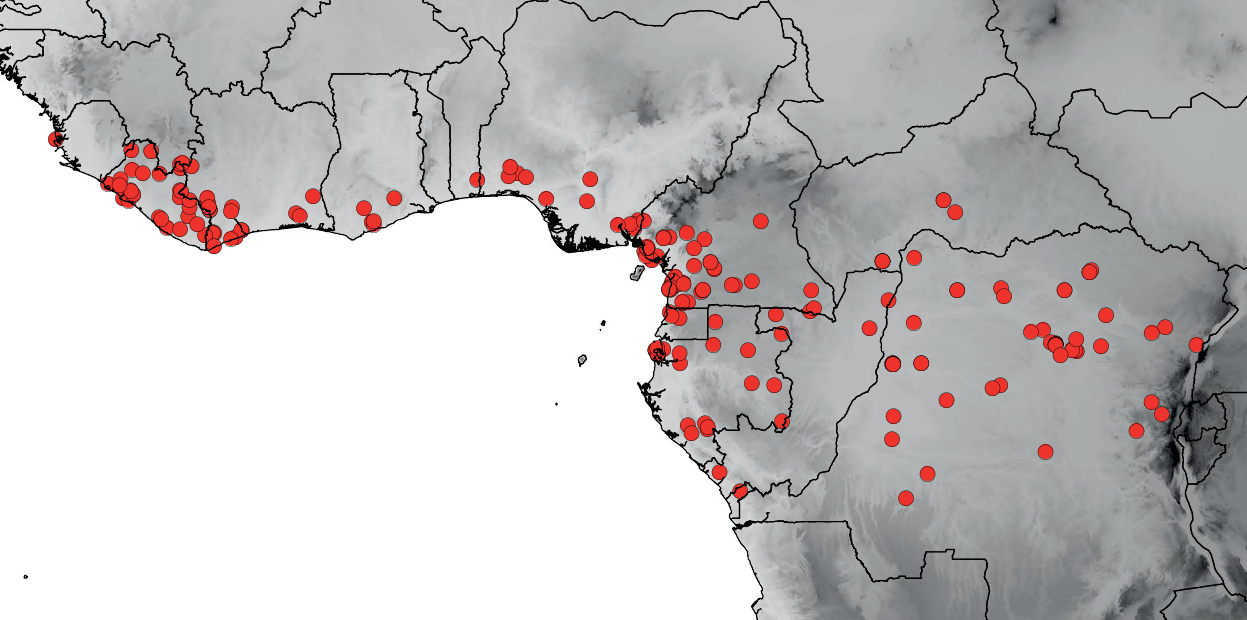
Figure 1 – Distribution of Kolobopetalum species combined. Map created with ArcMap (ArcGIS Desktop v.10.7.1; Esri 2019). © Esri and its licensors, all rights